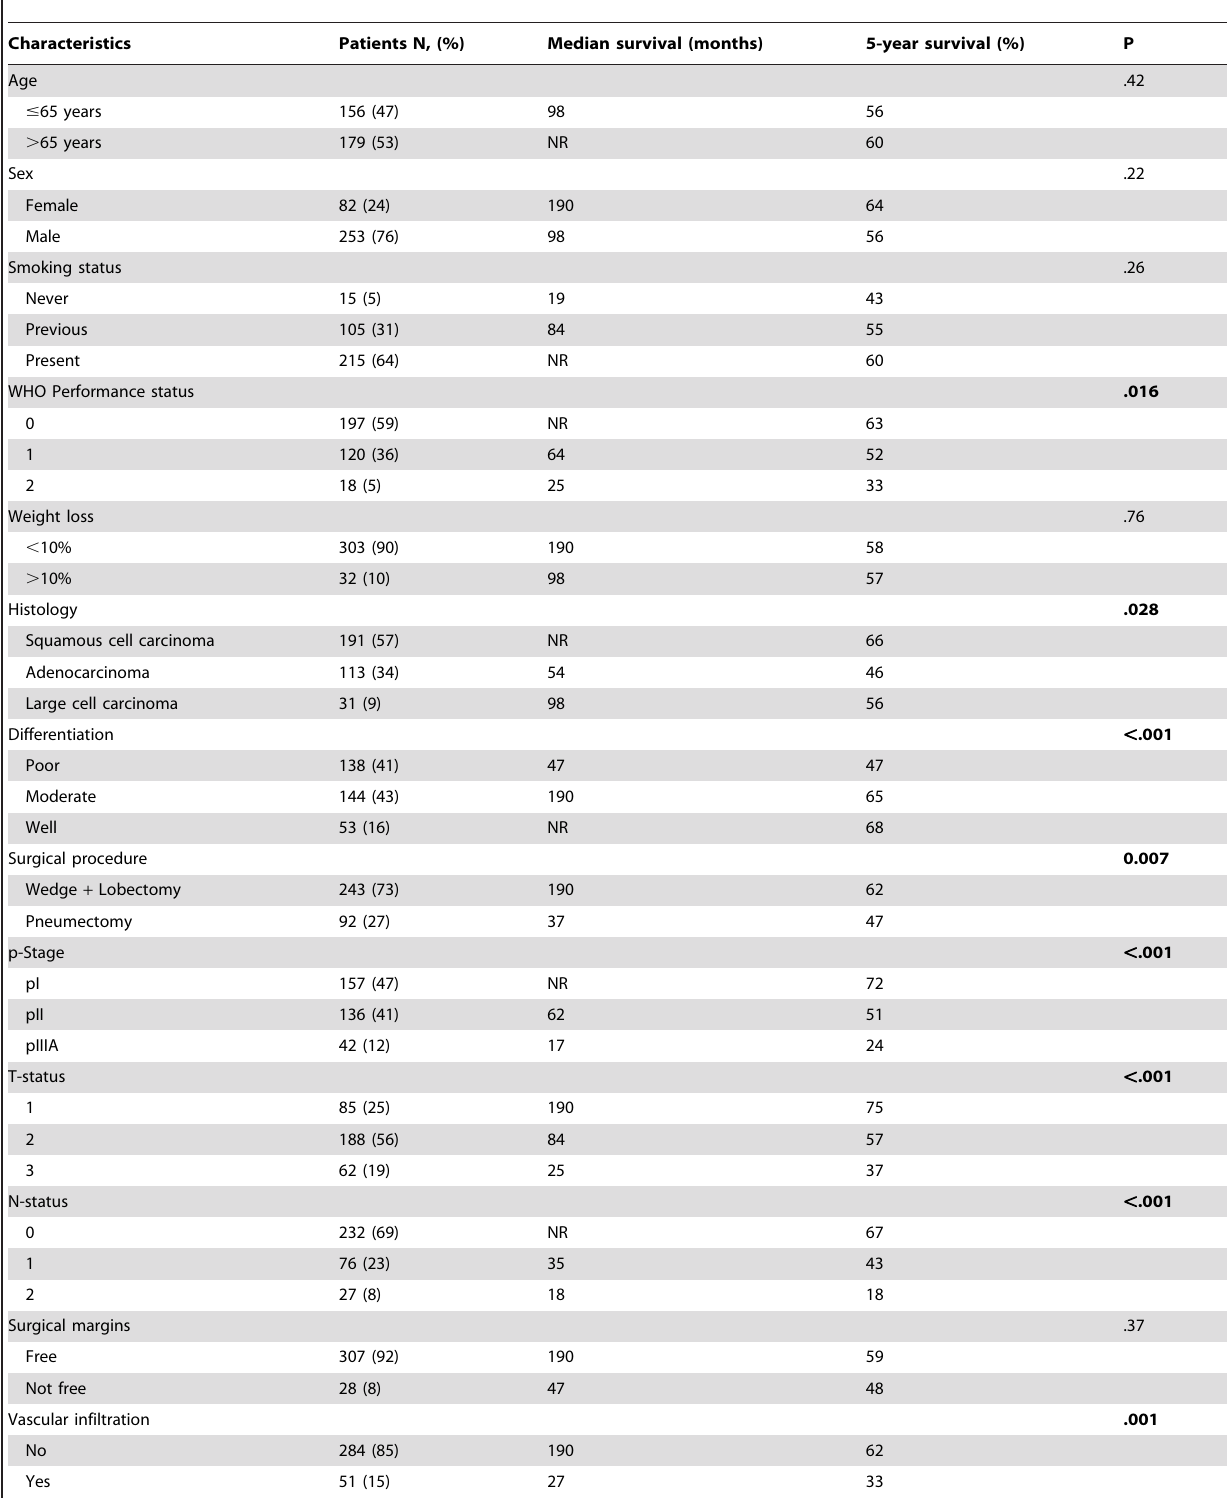
Table 1. Prognostic clinicopathologic variables as predictors of disease-specific survival in 335 NSCLC patients (univariate analyses; log-rank